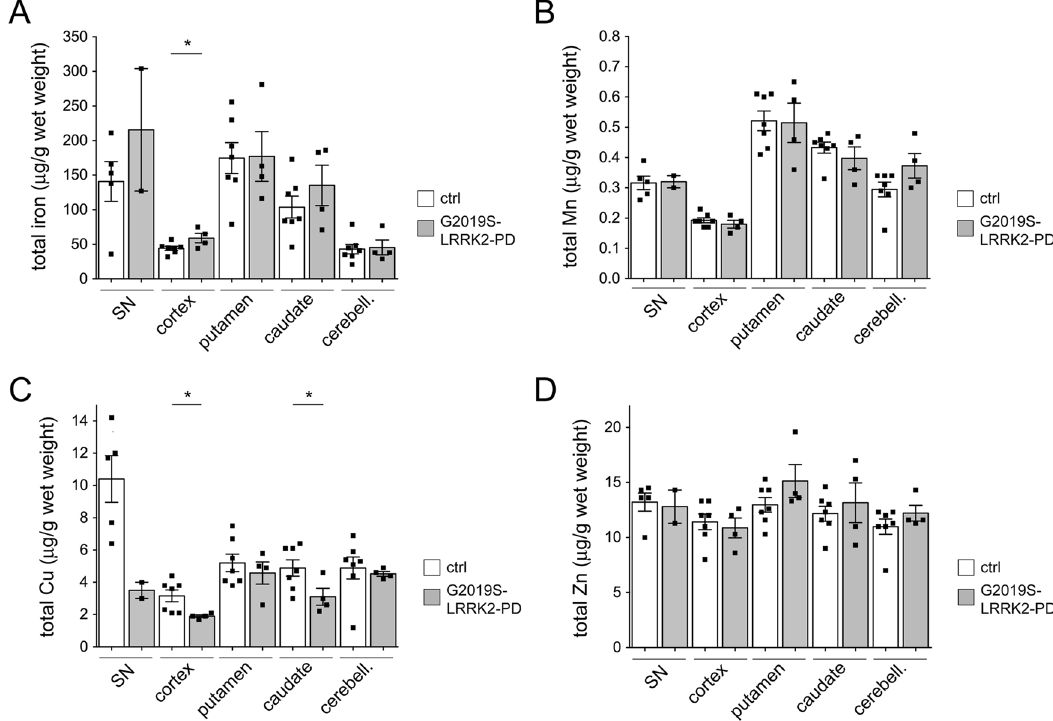
Fig. 1 Region-speci fi c alterations in total iron and copper content in the brains of G2019S-LRRK2 PD patients as compared to age- matched healthy controls. A Total iron content per wet weight of substantia nigra (SN), cortex, putamen, caudate, and cerebellum from seven age-matched healthy controls and four G2019S-LRRK2 PD patients. B As in A , but depicting total Mn content. C As in A , but depicting total Cu content. D As in A , but depicting total Zn content. Three independent tissue blocks from each brain region were analyzed, and analysis of each sample was performed in triplicates to obtain one mean value for each patient and brain region. Bars represent mean ± s.e.m. (* p < 0.05).